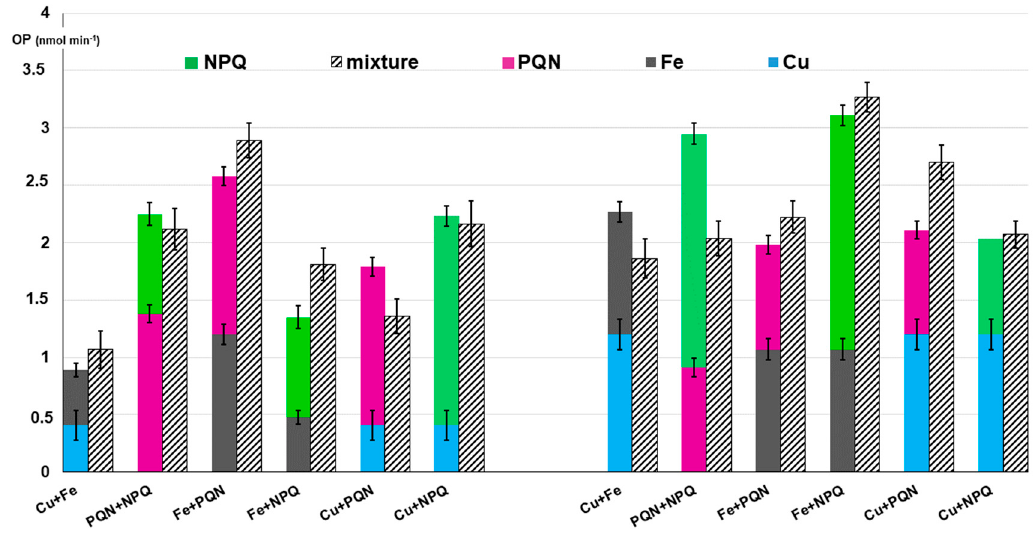
Figure 1. DTT consumption OP ( left side) and AA consumption ( right side) activities of Cu, Fe, PQN, NPQ and their binary mixtures at lower molar ratio. OP is expressed as nmol min − 1 . The concentrations of each metal and quinone in the binary mixtures are reported in Table 1, in the first line for each mixture. The colored bars indicate OP of each single compound, while the staked bars show OP experimentally measured on their binary mixtures. Error bars denote standard deviation (1 σ ) of triplicate analysis.